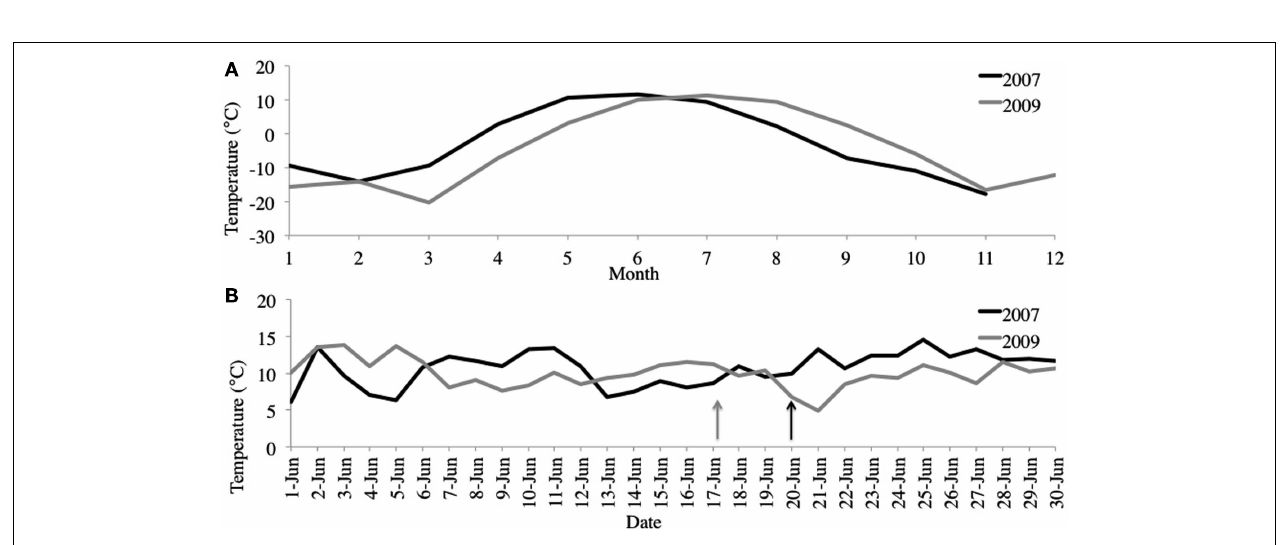
FIGURE 2 | BrayaSø water column. Left panel shows 2007 sampling profile, and right panel shows 2009 sampling profile. Arrows denote sample depth for the samples we sequenced Dissolved oxygen (DO) is decreased one order of magnitude and haptophyte rRNA gene copy number is decreased two orders of magnitude to plot along the same